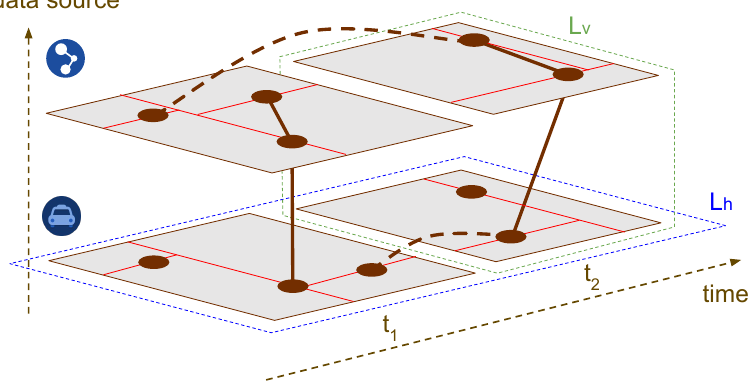
Figure 3. Example of Multi-Layer Geographical